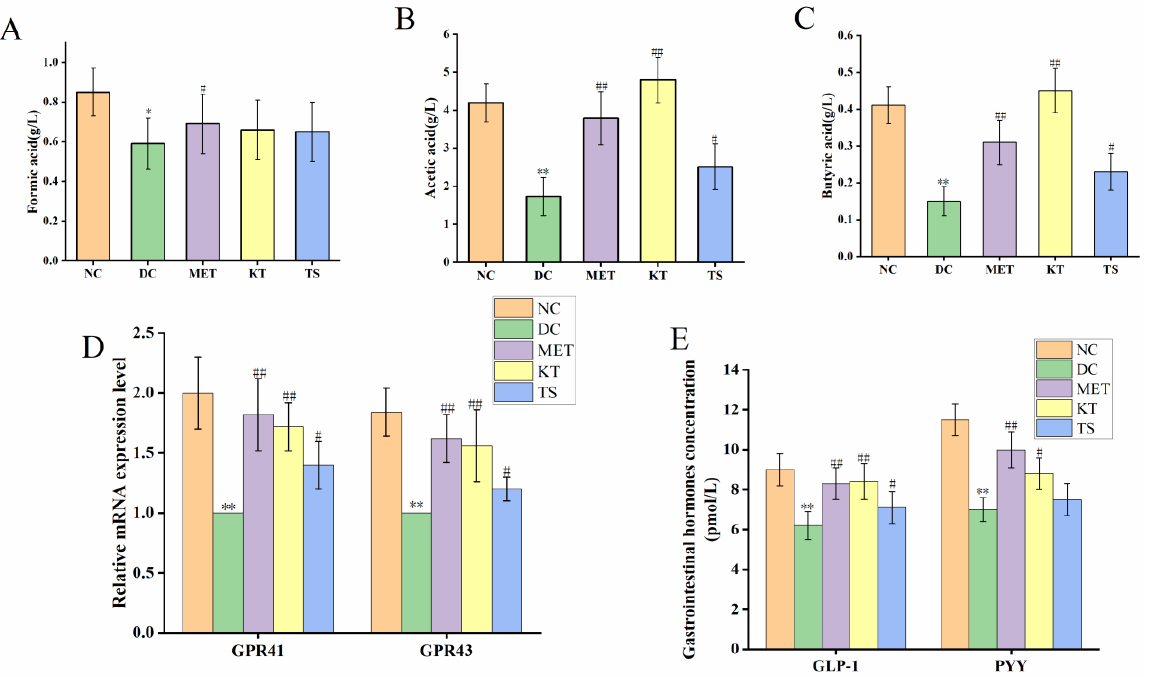
Figure 5. Kombucha regulated the intestinal metabolites in T2DM mice. ( A – C ) The content of SCFAs (formic acid, acetic acid, butyric acid) in the feces; ( D ) The mRNA levels of GPR41 and GPR43 in the colon tissue; ( E ) The levels of GLP-1 and PYY in the serum. * p < 0.05, ** p < 0.01 vs. Normal; # p < 0.05, ## p < 0.01 vs. Model.